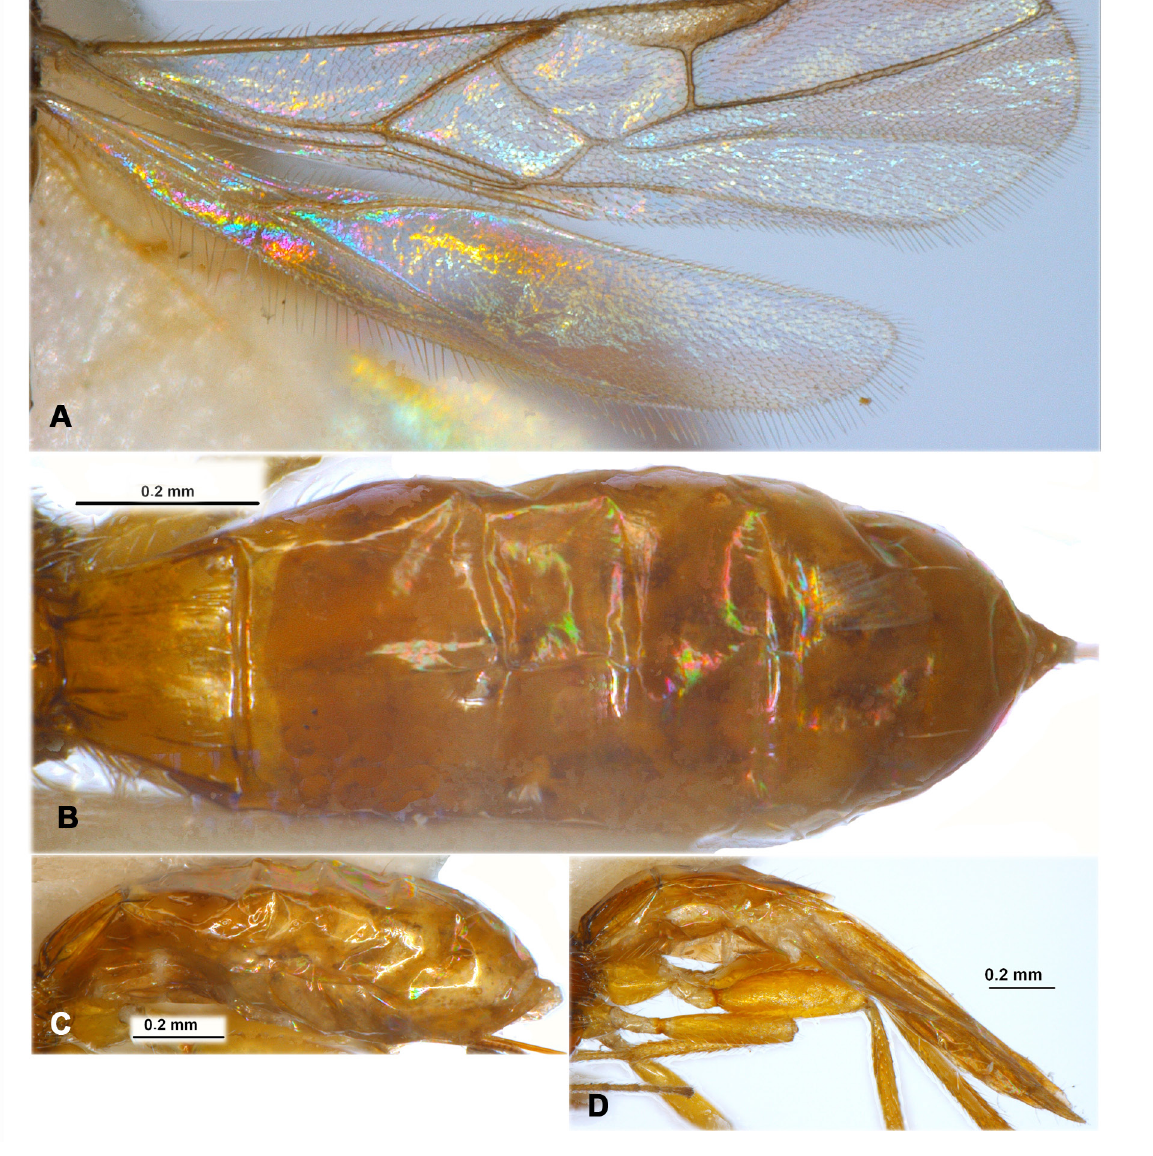
Fig. 64. Aivalykus microaciculatus Ranjith & Belokobylskij, 2020, paratypes. A–C . ♀ (RMNH). D . ♂ (RMNH). A . Wings. B . Metasoma, dorsal view. C–D . Metasoma, lateral